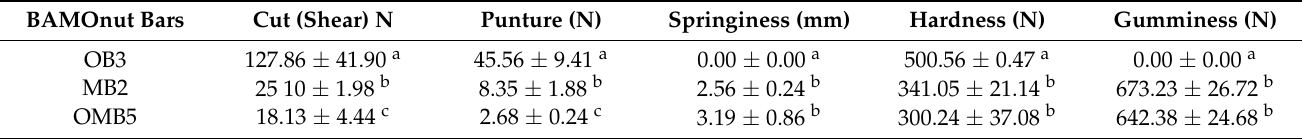
Table 6. Textural profile of Bambara groundnut- Moringa oleifera snack bars. BAMOnut